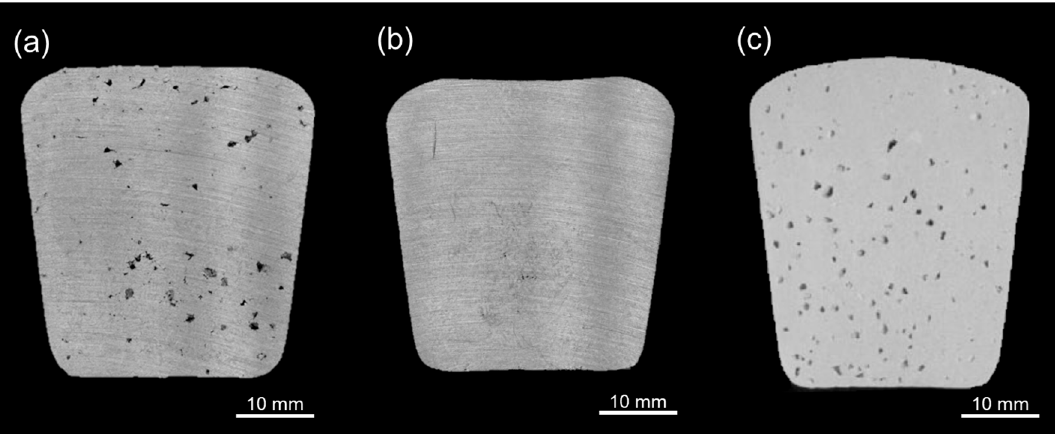
Table 2. Analysis of the porosity in RPT samples collected and solidified under partial vacuum during the in-line HSMC degassing process at a melt flow rate of 2 kg/min. Analysis of samples from [28]. Figure 7. Porosity of the vacuum RPT samples obtained after holding the melt for 1 h after degassing. ( a ) Rotary; ( b ) HSMC 0.1 L/min–3000 rpm; ( c ) HSMC 1 L/min–6000 rpm. [24,32]. Reprinted with permission from [32]. Copyright 2022 Elsevier.